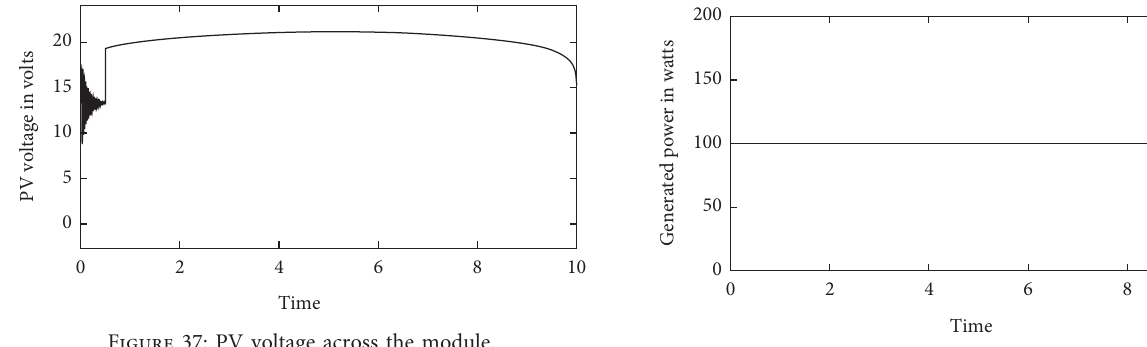
Figure 38: Battery only generated